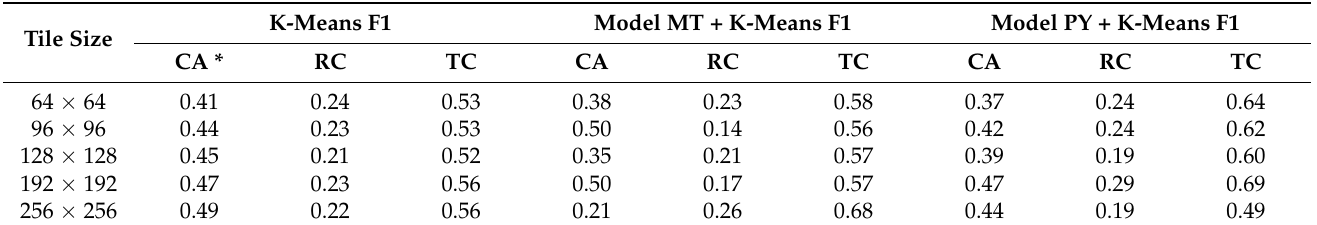
Table 10. F1 scores of the unsupervised learning methods for each unit in Pick Pit. Figure 9. Coloured cluster map of the Top Pit orthomosaic using ISO Cluster Classification Tool for four classes.